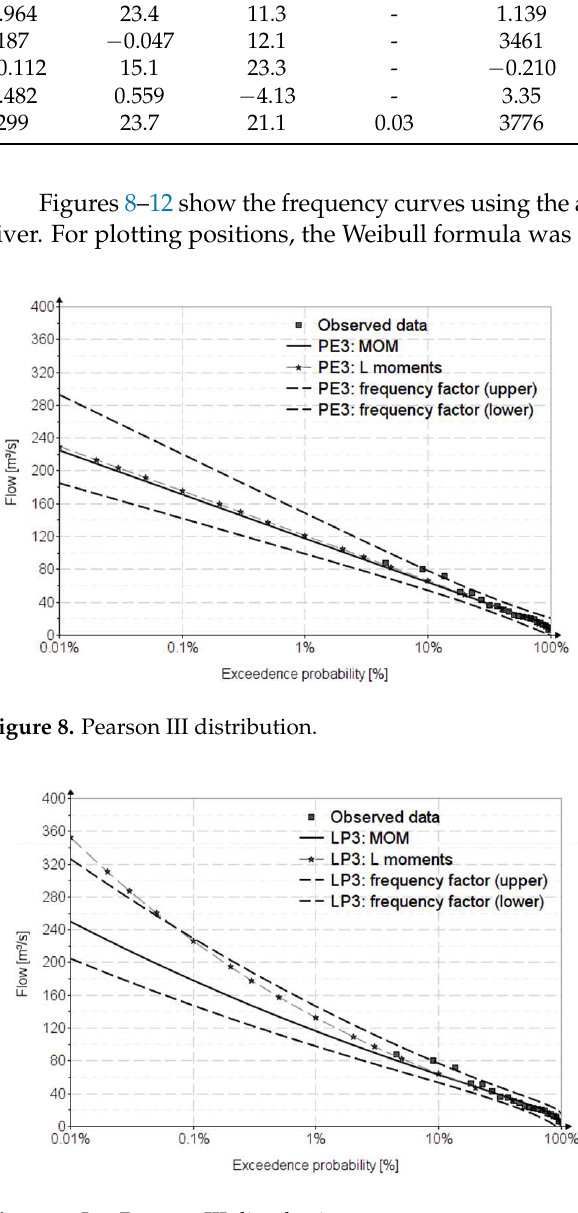
Table 5. Parameter estimates by the MOM and L-moments.